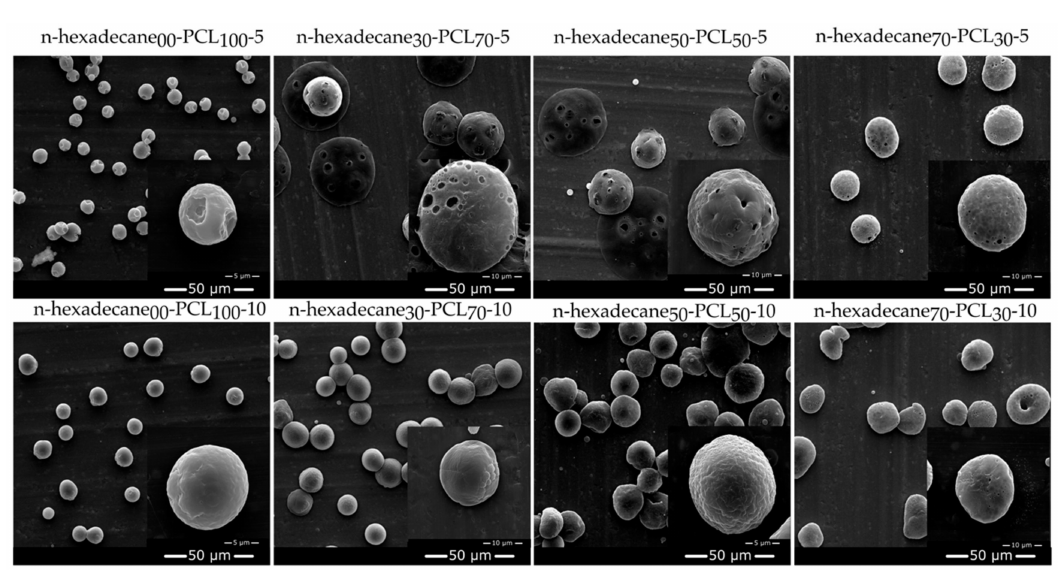
Figure 2. Surface state and morphologies of PCL, and PCM-PCL microparticles obtained from SEM